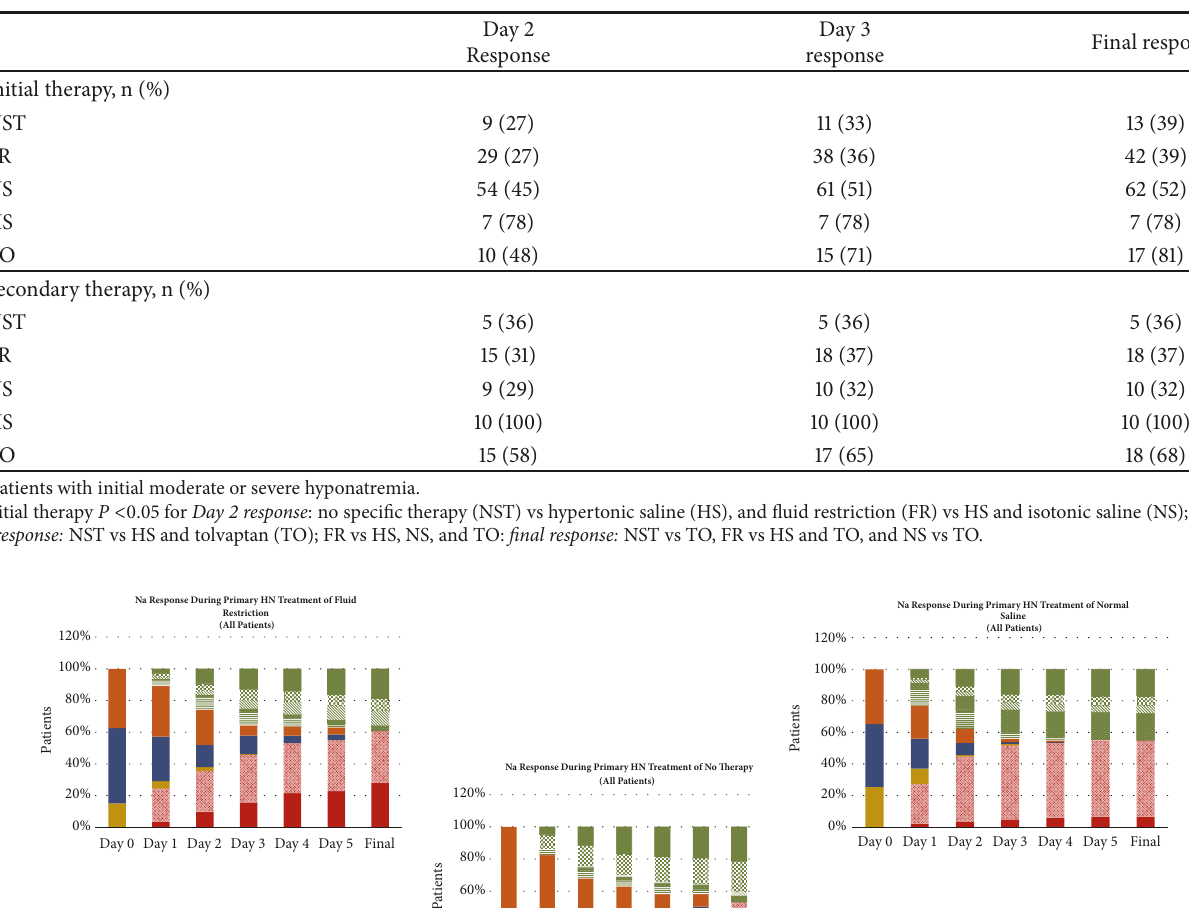
Table 3: Patients with [Na + ] ≥ 5mmol/L in response to initial and secondary therapy a .